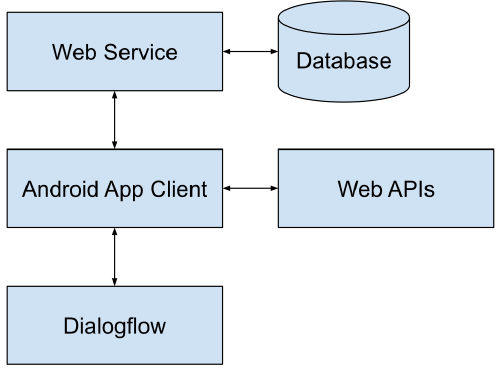
Figure 1. System architecture